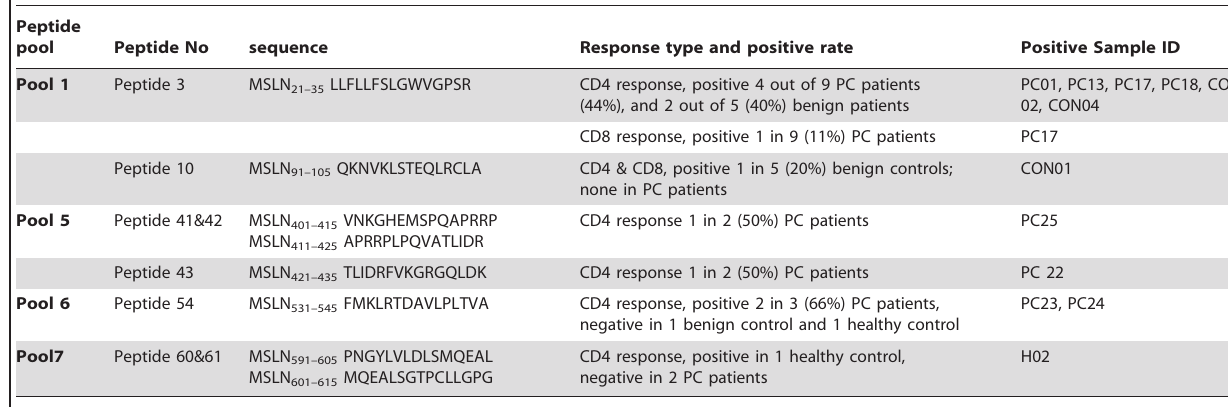
Table 4. Identified individual reacting